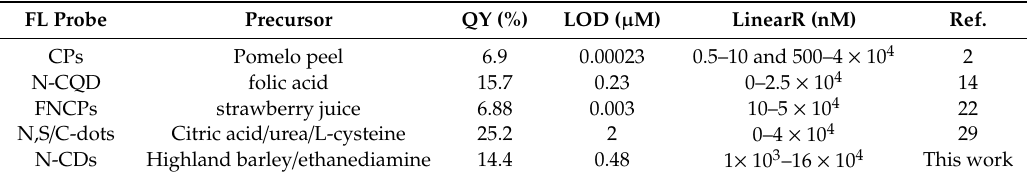
Table 1. Comparison of di ff erent CDs for Hg 2 + .